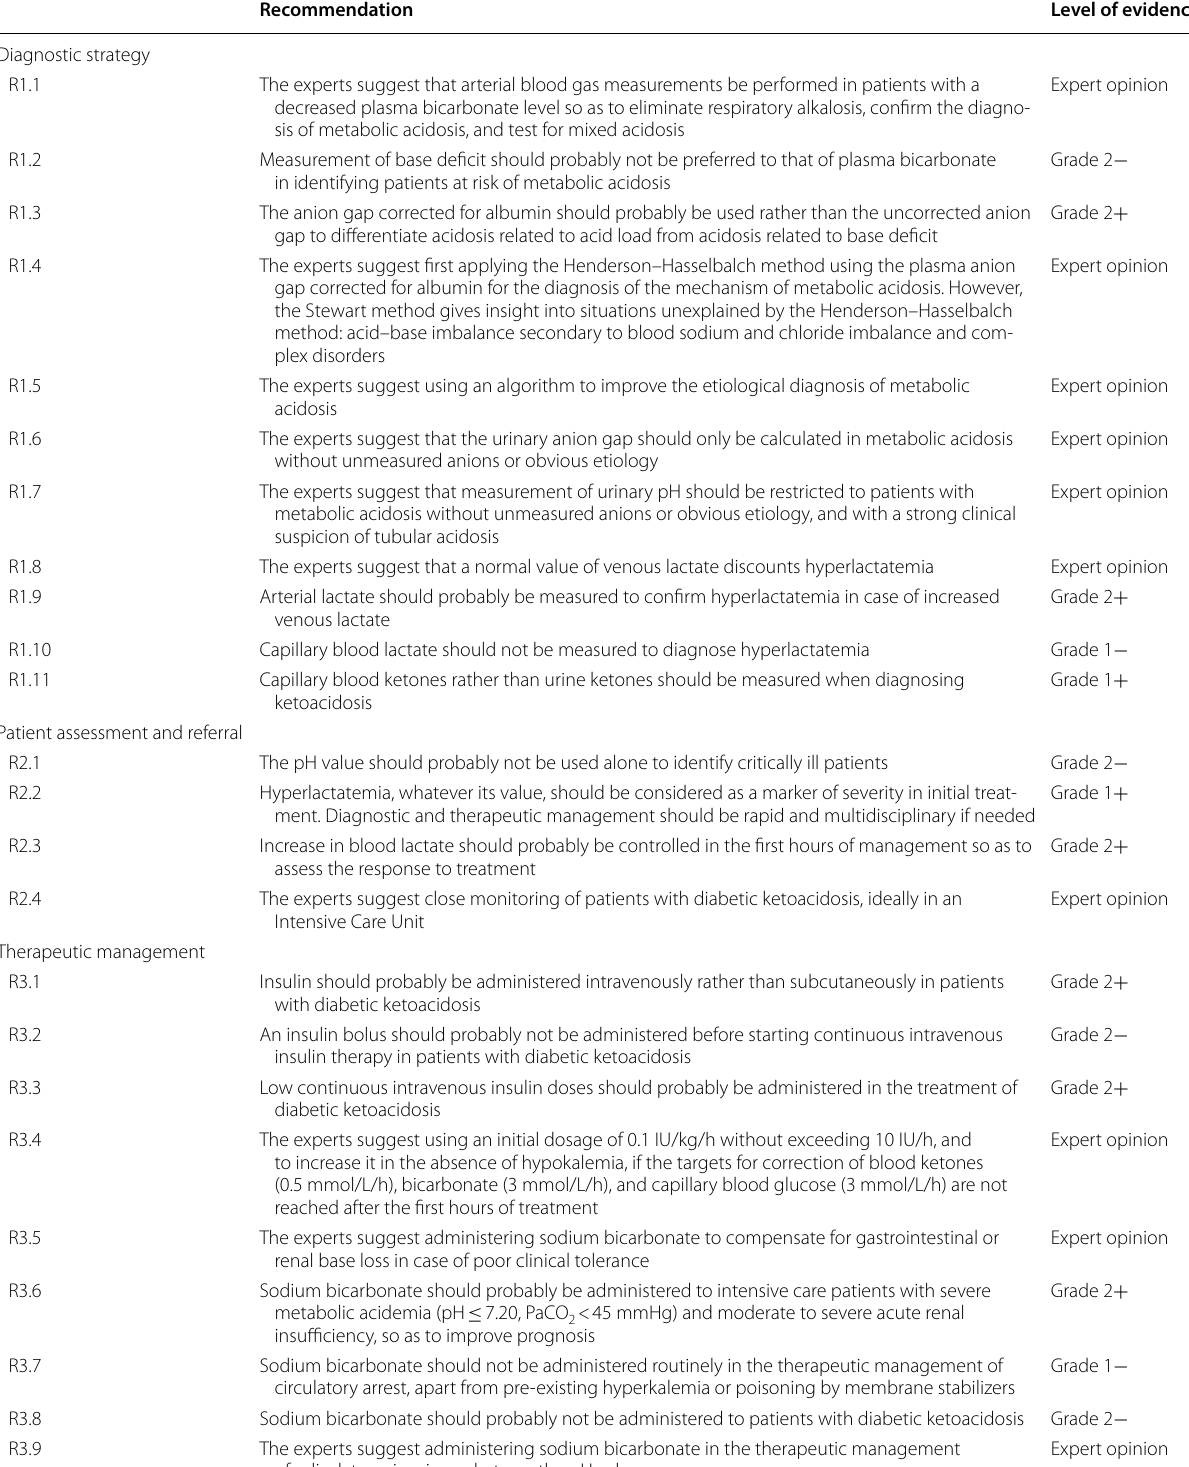
Table 2 Summary of